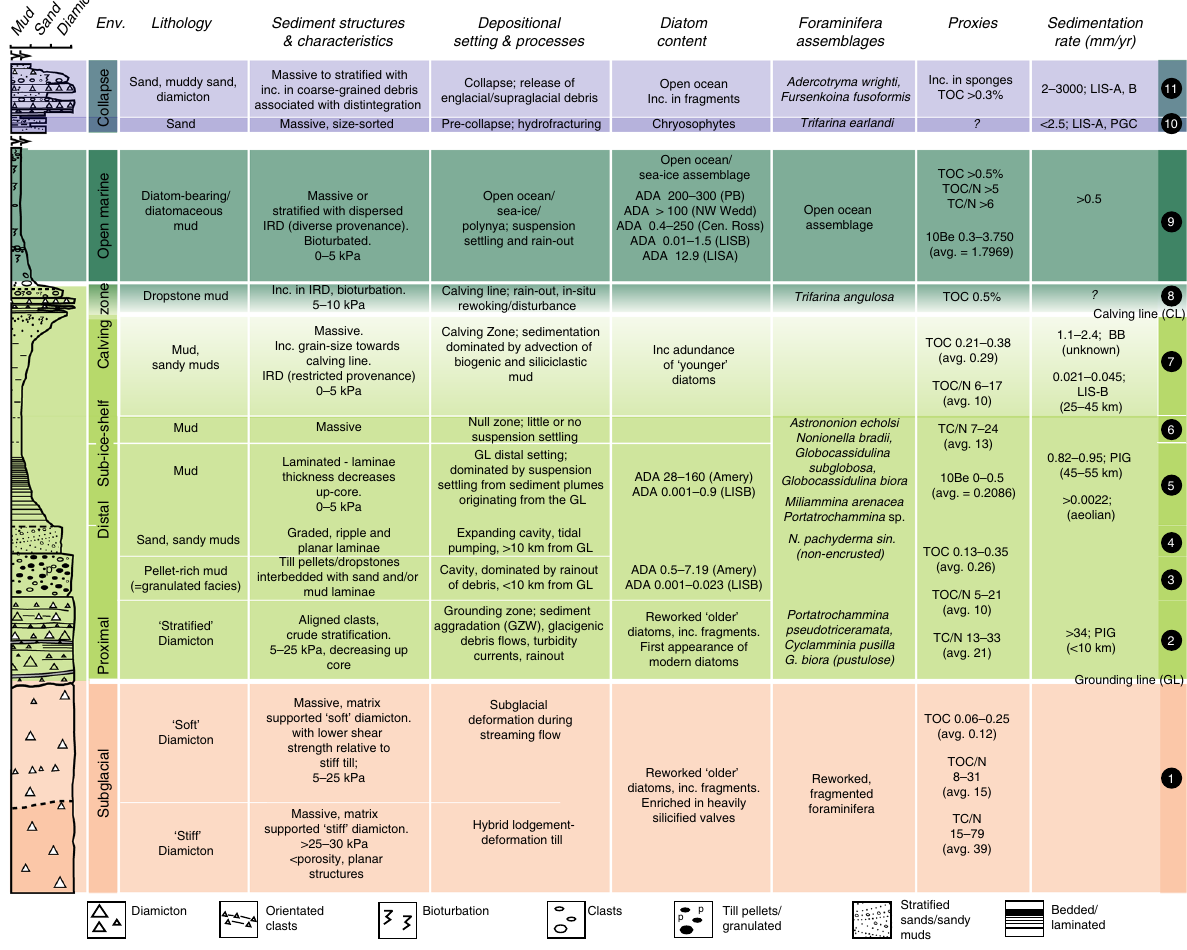
Fig. 4 Idealised sedimentary sequence deposited under a retreating ice shelf (modi fi ed from refs. 53,147 ). This full succession is rarely preserved, although the general transition from coarse-grained grounding line (GL) proximal to fi ner-grained grounding line distal sediments is typical. A ‘ collapse facies ’ is summarised in the upper panel and can occur anywhere within the ‘ sub-ice-shelf ’ succession. Black numbered circles (right column) refer to the ‘ sediment elements ’ shown in Fig. 5. LISA, LISB Larsen A, B ice shelf, PGC Prince Gustav Channel Ice Shelf, BB Barilari Bay, PIG Pine Island Glacier, PB Prydz Bay. Sedimentation rates from refs. 16,23,118 ; number in parenthesis is distance from GL. Absolute diatom abundance (ADA; millions of valves/gram sediment) 17,22,63,64,96 . Percentage total organic carbon (TOC)/Nitrogen (N) and total carbon (TC)/N data 16,63 together with unpublished data from George VI and Larsen C sub-ice-shelf